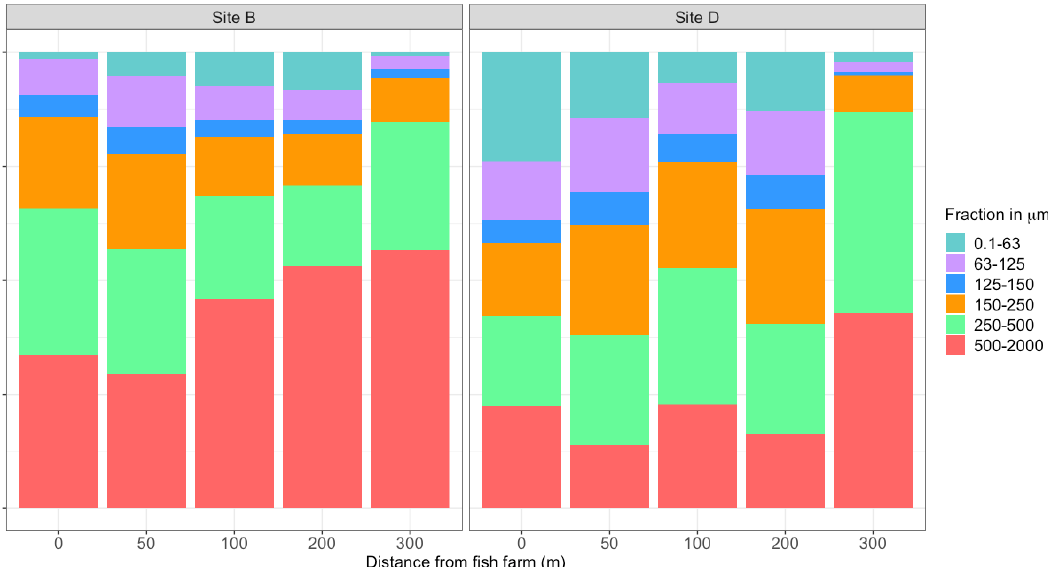
Figure 3. Plot of total organic carbon percentage and organic C:N ratio by station along transects. Asterisks represent statistically significant difference between different stations (***: p -value < 0.001; **: p -value < 0.01; *: p -value < 0.05). 3.2. Foraminiferal Analyses 3.2.1. Abundance and Diversity Foraminiferal analysis of the 125–500 µm fraction revealed a heterogeneity between samples in terms of density of foraminifera for 50 cm 2 (ind.50 cm −2 ). Densities varied from 126 ind.50 cm −2 (station B300) to a maximum of 732 ind.50 cm −2 (station D0; Figure 4, Table S1). Stations under the fish farms (i.e., B0, B50, and D0) exhibited higher densities than stations further away from the fish farms (Figure 4).